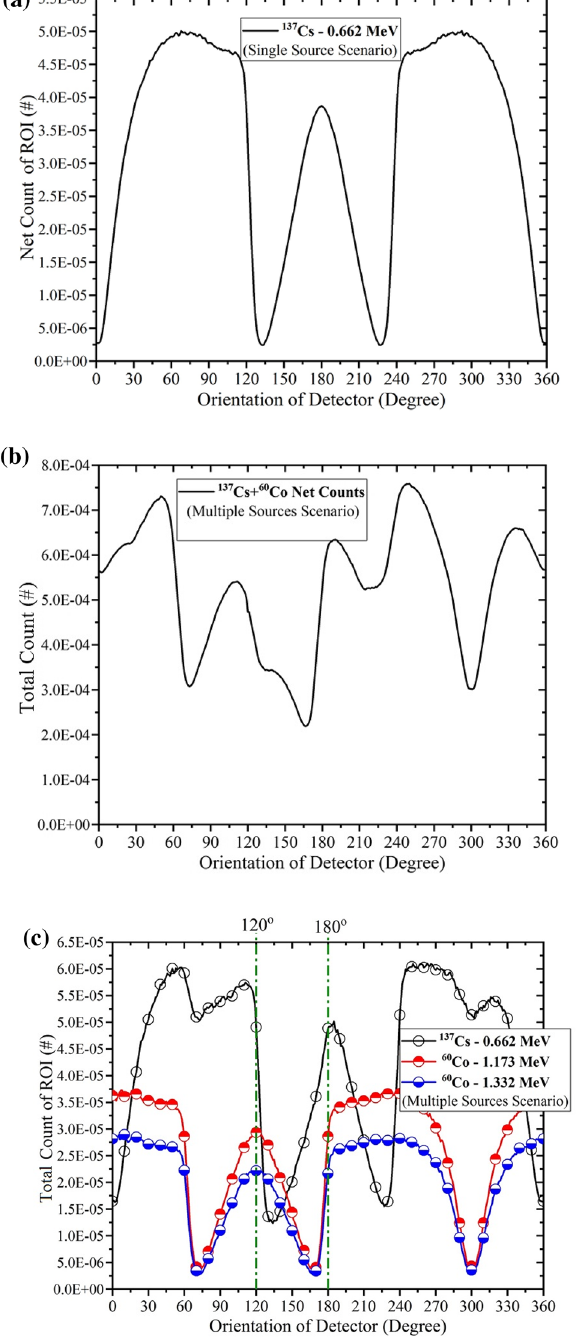
Figure 5. ( a ) net count of ROI (per particle) in presence of a single isotropic 137 Cs gamma-ray source versus orientation of detector (single source’s scenario). ( b ) total count (per particle) in presence of an isotropic 137 Cs gamma-ray source and an isotropic 60 Co gamma-ray source (simultaneously, multiple sources’ scenario). ( c ) total count of ROI of gamma-rays (per particle) which is due to presence of 137 Cs and 60 Co versus orientation of